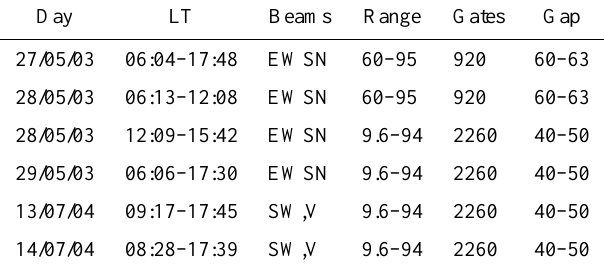
Fig. 2. Example spectrum (blue) overlaid with yellow, green, and red symbols corresponding to three different fitting procedures de- scribed in the text. Spectral width estimates obtained with six dif- ferent methods are shown as horizontal lines (with matching colors to the diamonds). The green and red data points indicate spectral widths obtained from logarithmic fits applied with spectral models (4) and (5) result in comparable widths shown in green and red, respectively. Spectral moment calculation (blue) and linear gener- alized Gaussian fit (yellow) give slightly wider estimates. Estimates obtained from the correlation times, with (black) and without (cyan) accounting for triangular weights are the largest for this spectrum.